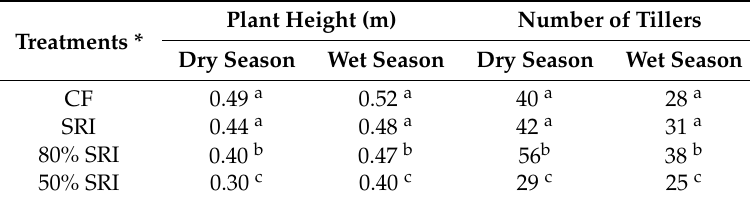
Table 2. Plant height and number of tillers for the dry and wet seasons. Treatments *